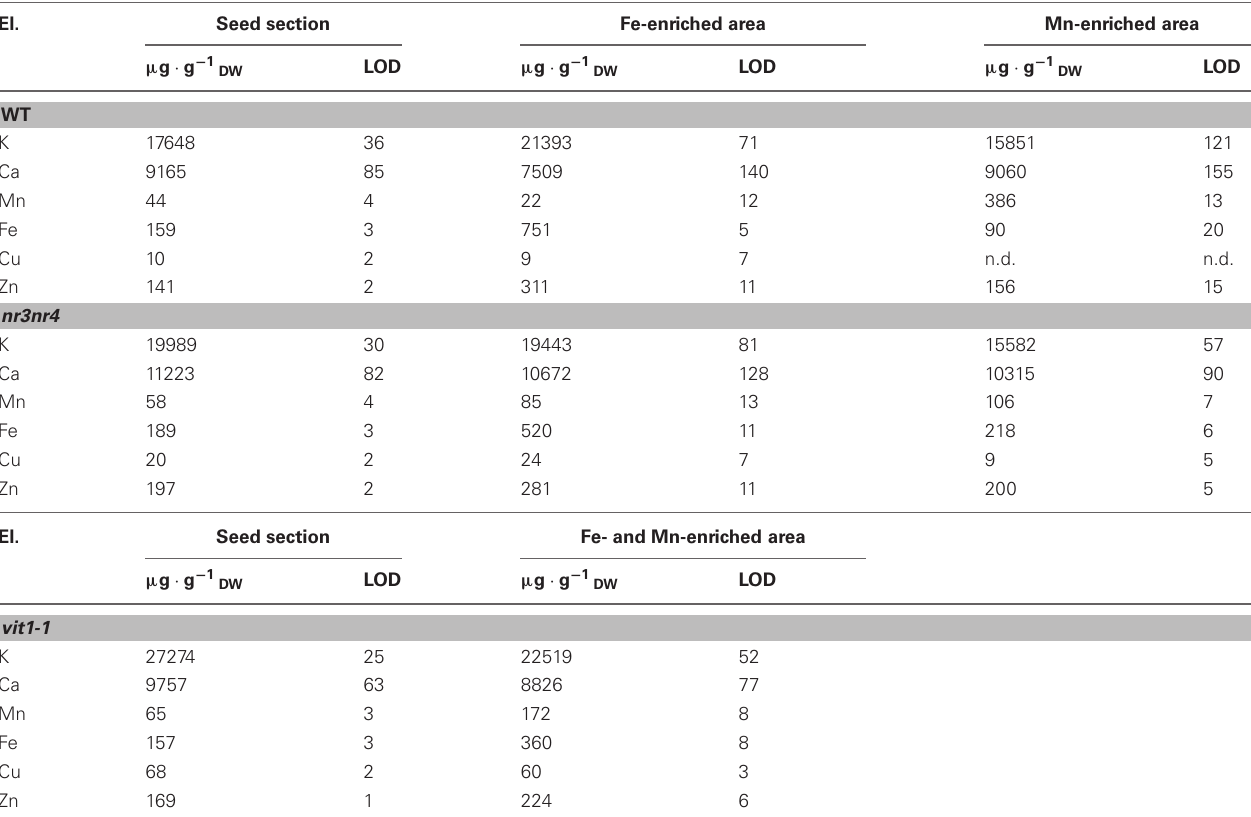
Table 2 | µ PIXE quantification of various elements in three different Arabidopsis thaliana seed genotypes with emphasis on Fe- and Mn-enriched areas.